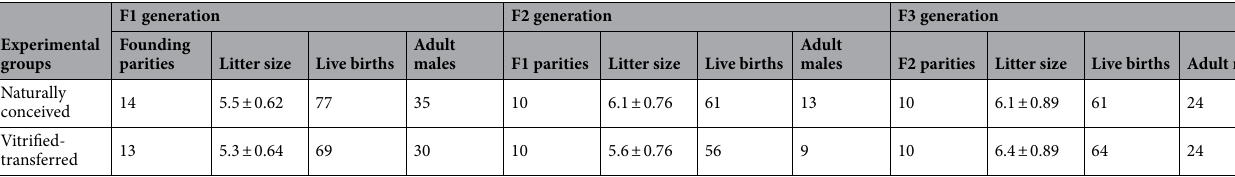
Table 1. Efficiency in the establishment of the naturally conceived and vitrified-transferred progenies across three generations (F1, F2, F3). In F1 generation, naturally-conceived animals were generated from 14 pregnant females following natural conception, without embryo manipulation. Instead, vitrified-transferred animals were generated from vitrified-warmed embryos transferred in 13 foster mothers. F2 and F3 generations were produced selecting randomly one mature female and male from each parity of the previous generation. To reduce the inbreeding, mating between animals with common grandparents was avoided. Thereby, 10 F1 and 10 F2 parities generated F2 and F3 population, respectively.